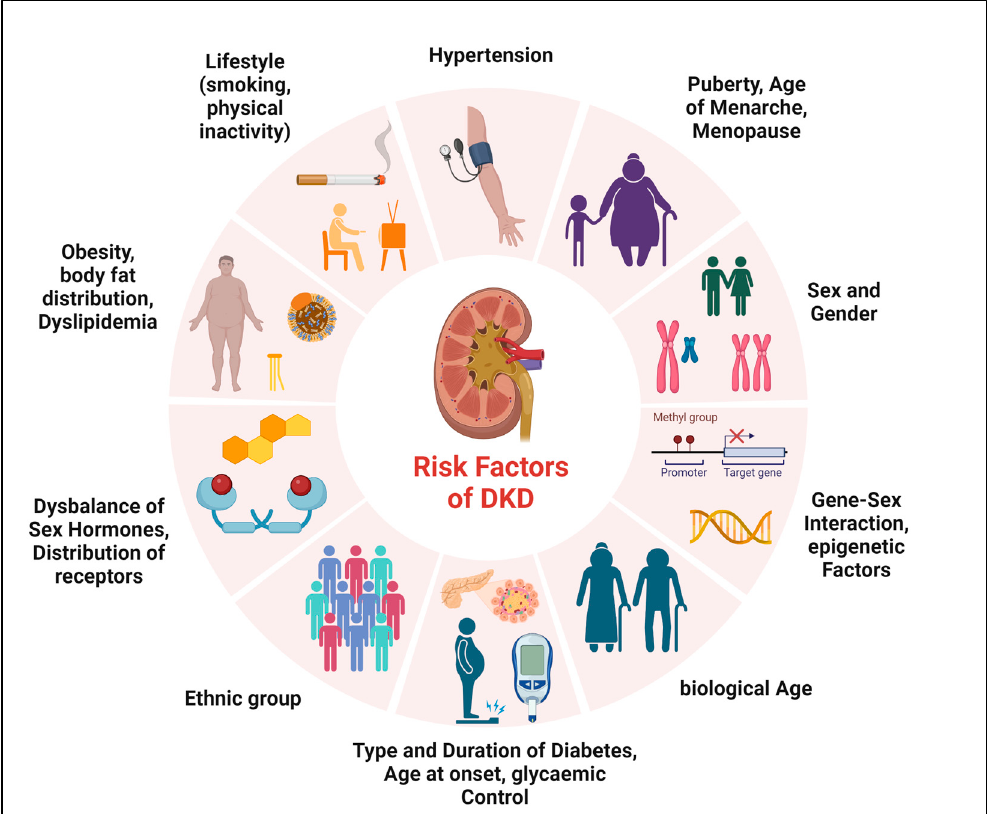
Figure 1. Determinants of sex di ff erences in DKD. Various factors may be determinants of sex differences in the development and progression of DKD.